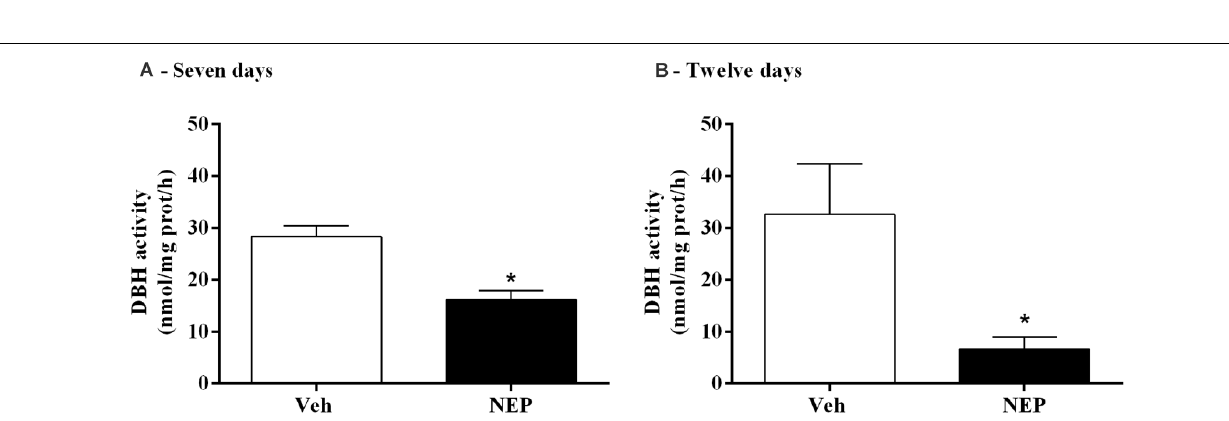
liver ( t (10) = 2.55, p = 0.0288, Cohen’s d = 1.35; Figure 7B ), heart ( t (14) = 7.64, p < 0.0001, Cohen’s d = 3.82; Figure 7C ), and plasma ( t (14) = 3.69, p = 0.0024, Cohen’s d = 1.84; Figure 7D ) of mice in the PTSD-group and treated with nepicastat compared to mice treated with vehicle. No significant differences were observed in NA in the hippocampus ( t (14) = 0.98, p = 0.3479, Cohen’s d = 0.49; Figure 7E ) and in the amygdala ( t (14) = 1.765,